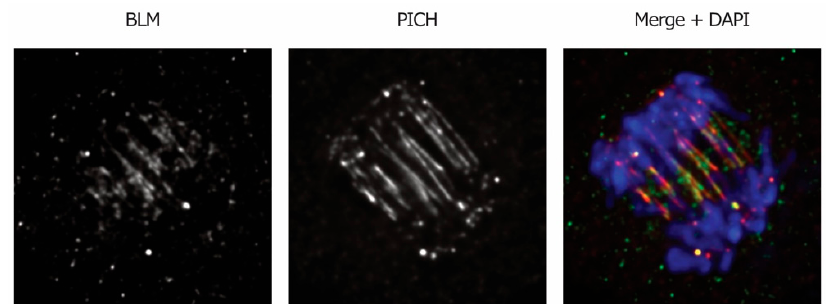
Figure 4. BLM and PICH associate with ultra-fine bridges (UFBs). UFBs were detected in RPE-1 cell treated with low doses of topoisomerase TOP2A inhibitor (ICRF193) by staining of BLM (in green) and PICH (in red). DNA was stained with 4 ′ ,6-diamidino-2-phenylindole (DAPI, in blue). Deconvolved images are shown. Courtesy images provided by María Fernández-Casañas.